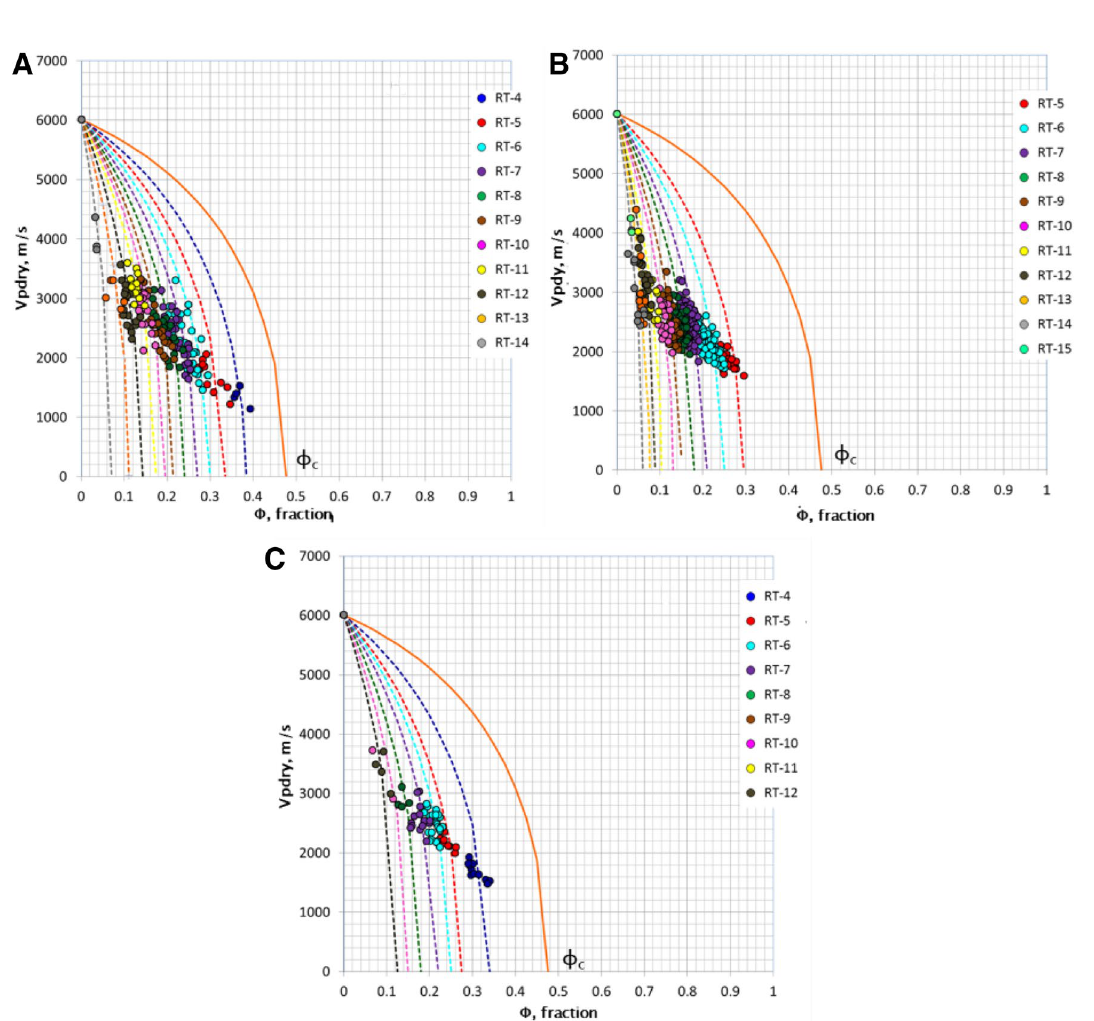
Fig. 3 Plot V pdry versus porosity for each rock type for data set 1 ( a ), 2 ( b ) and 3 ( c ) (colored dashed line is derived with different critical poros- ity value for each rock